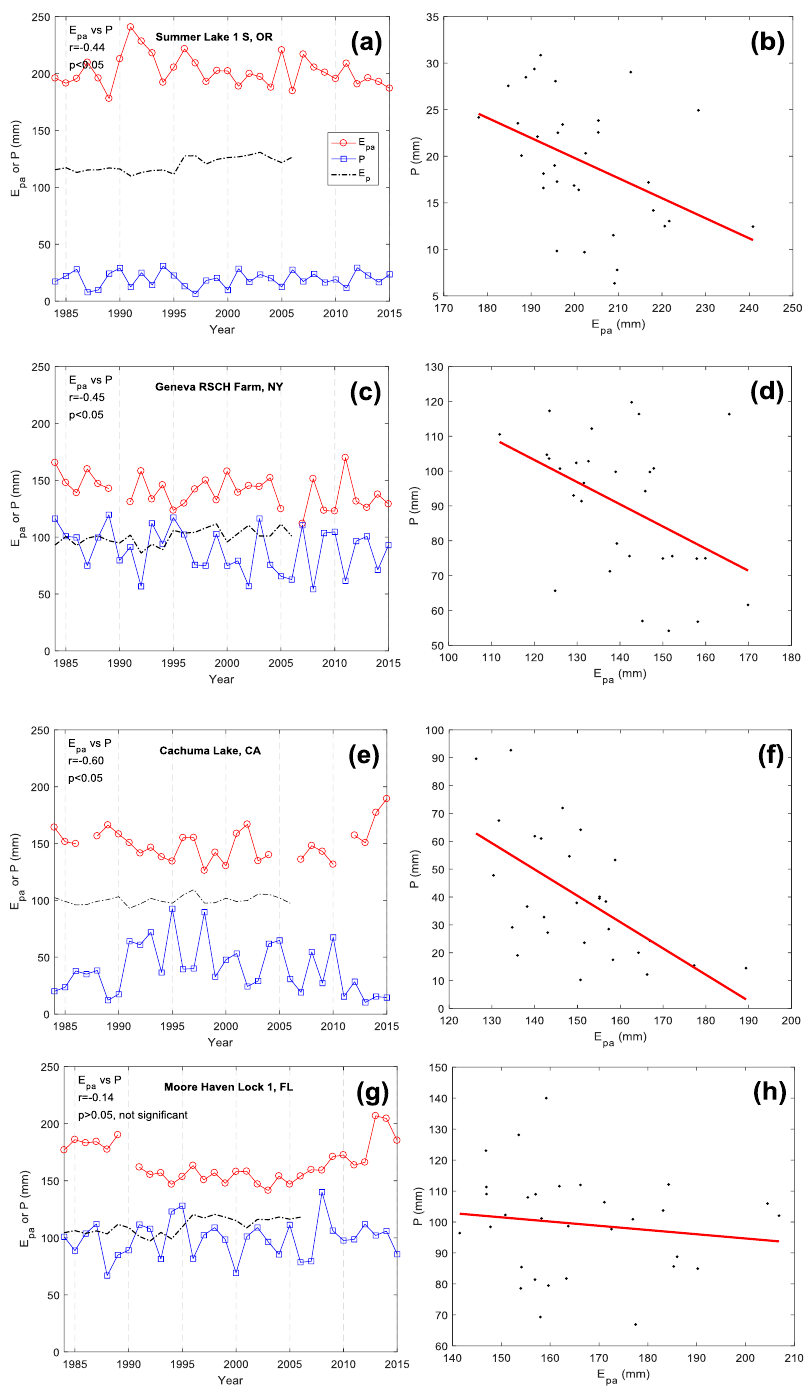
Figure 6. Warm-season P , E p and E pa time series of four example weather stations in the study period of 1984–2015: (a) Summer Lake 1S, OR (42 ◦ 58 (cid:48) N, 120 ◦ 47 (cid:48) W); (c) Geneva RSCH Farm, NY (42 ◦ 53 (cid:48) N, 77 ◦ 20 (cid:48) W); (e) Cachuma Lake, CA (34 ◦ 35 (cid:48) N, 119 ◦ 59 (cid:48) W); (g) Moore Haven Lock 1, FL (26 ◦ 50 (cid:48) N, 81 ◦ 50 (cid:48) W); and the scatterplots of P vs. E pa at the four example stations (b, d, f, h)